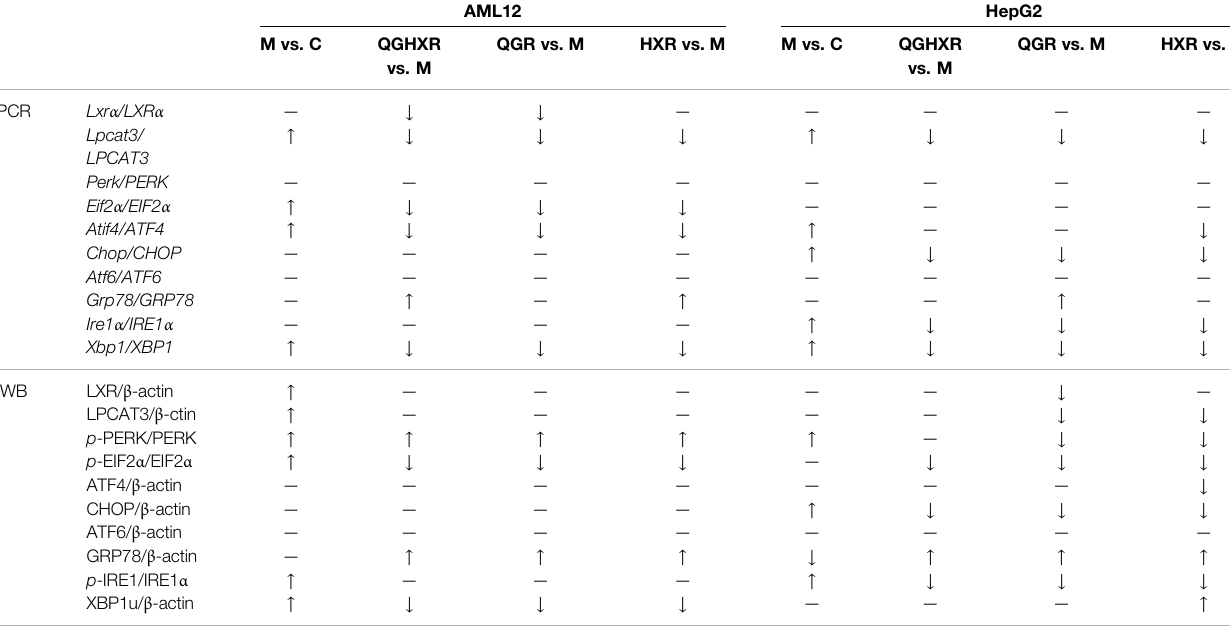
TABLE 2 | Protective effect of QGHXR against alcohol-induced liver injury in AML12 and HepG2 cell through the LXR α -LPCAT3-ERS pathway. AML12